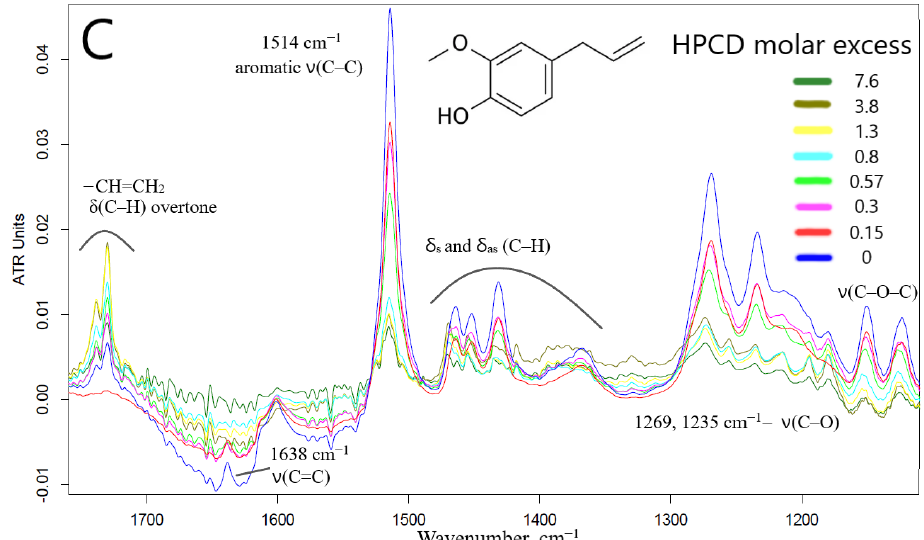
Figure 2. ( A ) FTIR spectra of apiol (15.8 mM) and its inclusion complexes with HPCD. ( B ) Second derivative (d 2 A/d ν 2 ) of FTIR spectra from ( A ). ( C ) FTIR spectra of EG, 15 mM and its inclusion complexes with HPCD. Conditions and mathematical calculations are given in Methods section (Sections 3.5 and 3.7). Spectra of HPCD in the corresponding concentration were subtracted as background.